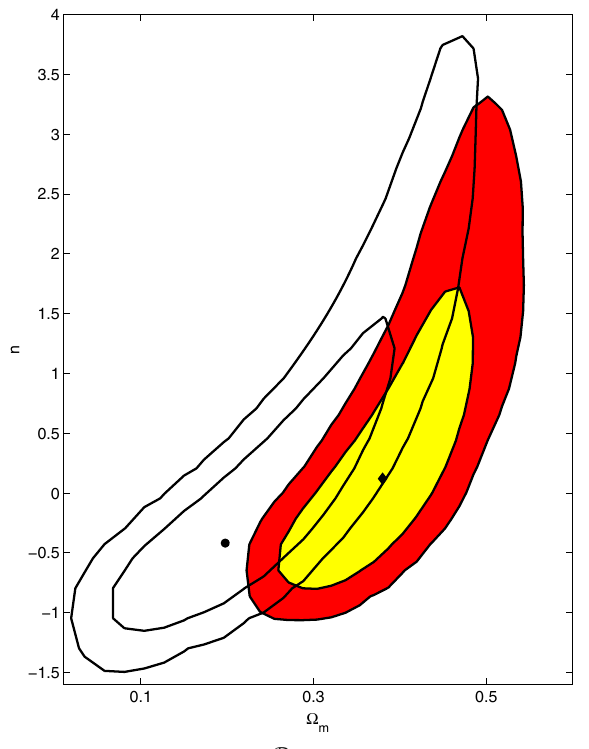
D 0 , n ) plane for the averaged effective model with zero Fig. 61 Supernova and CMB constraints in the (Ω m Friedmannian curvature (filled ellipses) and for a standard flat FLRW model with a quintessence field with constant equation of state w = − ( n + 3 )/ 3 (black ellipses). The disk and diamond represent the absolute best-fit models respectively for the standard FLRW model and the averaged effective